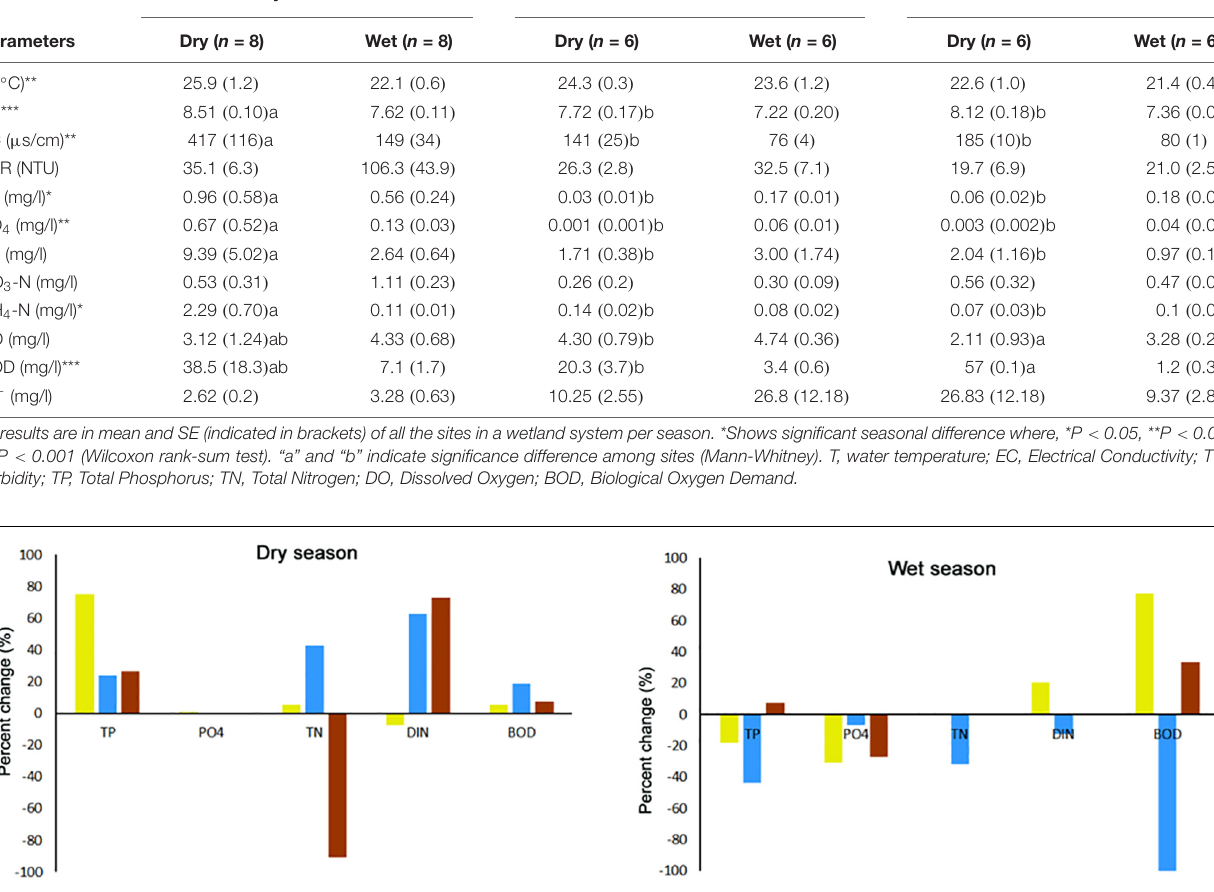
TABLE 1 | Comparison of physicochemical water quality parameters between the dry and the wet seasons in each of the three wetlands and among Boye, Kito, and Fisho wetlands of southwestern Ethiopia using Mann-Whitney and Wilcoxon rank-sum tests, respectively. Boye wetland Fisho wetland Kitto wetland